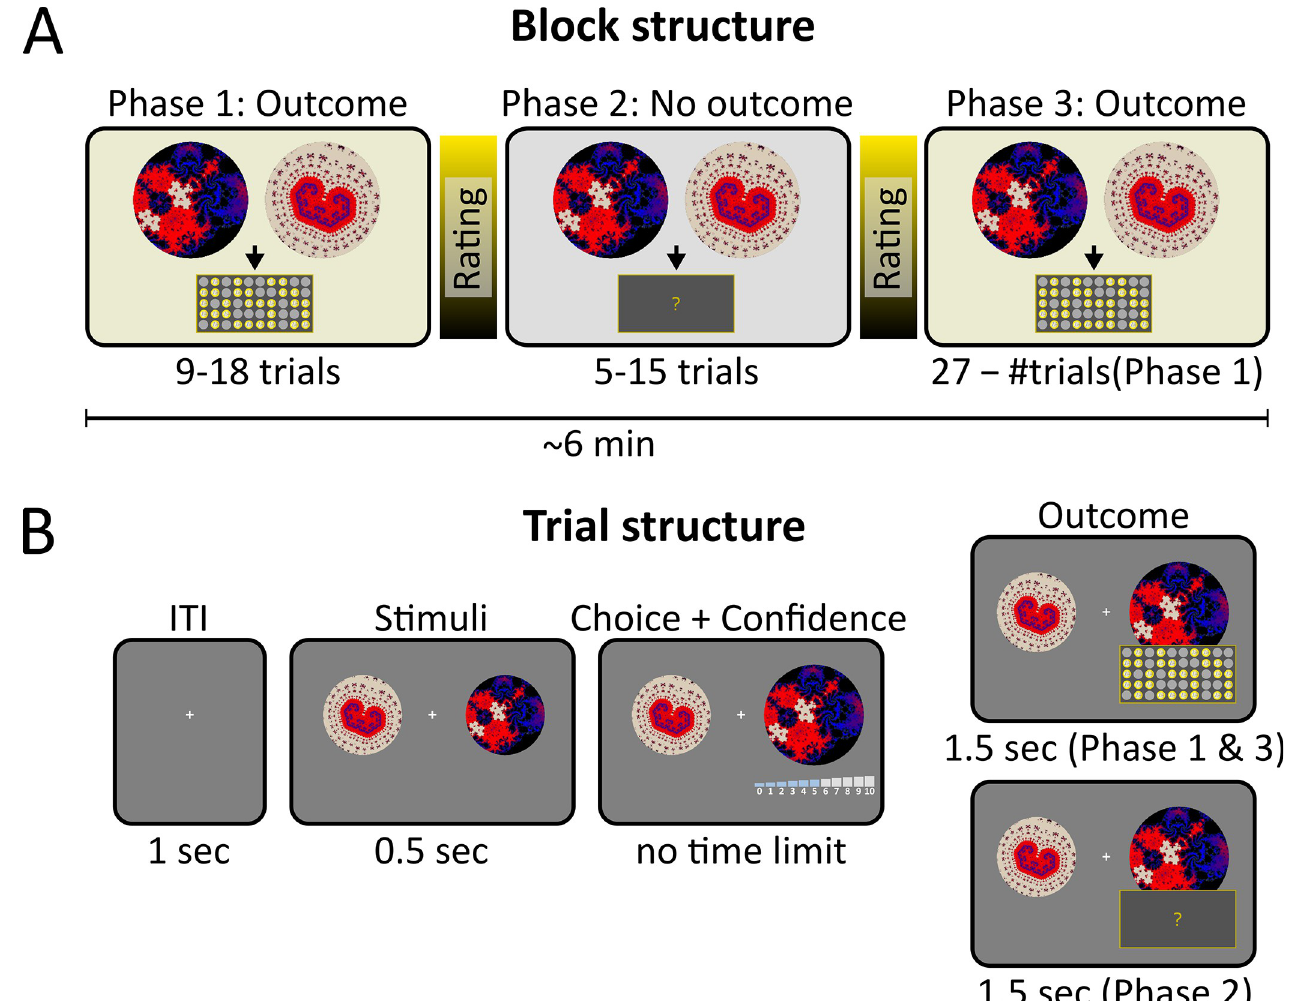
Fig 1. Experimental design. (A) Block structure. In each block, participants had to learn about the values of five CS based on the feedback in phases 1 and 3. The critical phase was a period of 5–15 trials in-between phases 1 and 3 in which participants did not receive feedback (phase 2). Before and after phase 2, participants rated the values of each CS on a continuous scale. (B) Trial structure. In each trial, participants chose between two CS and indicated their confidence on a scale from 0 to 10. In phases 1 and 3, the reward outcome for the chosen option was presented in the form of a scratch card with 50 fields, each of which could contain a 1 EUR coin or a blank. In phase 2, the scratch card was not revealed; however, participants were instructed that they would receive the hidden reward on the scratch card at the end of the